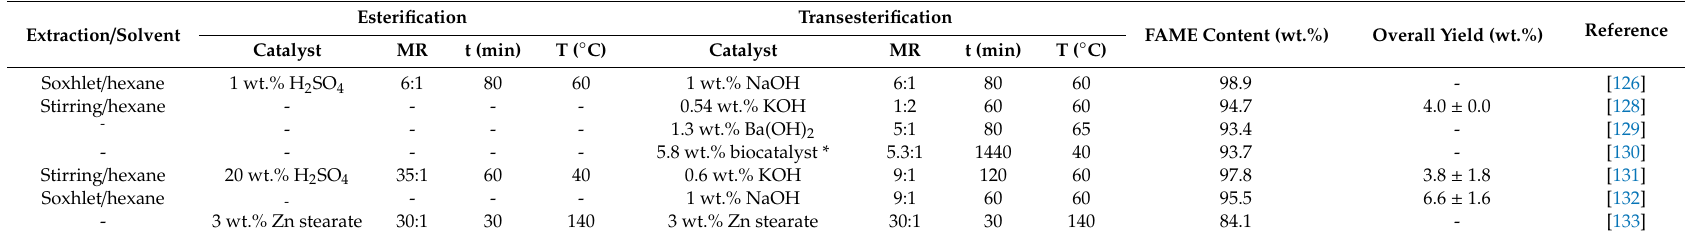
Table 8. Procedures and fatty acid methyl esters (FAME) content achieved in the production of biodiesel from olive pomaces. Esterification Transesterification Extraction / Solvent